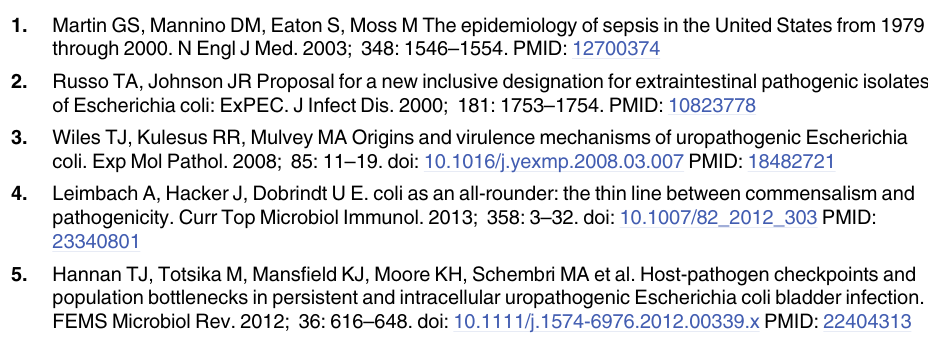
S6 Fig. Flow cytometry analysis of the Gr1 + and CD11b + populations. (A and B) Flow cy- tometry analysis of peripheral blood isolated from mice intravenously infected with 10 7 CFUs of (A) E . coli CNF1+ , E . coli CNF1- (B) E . coli CNF1+HLY- , or E . coli CNF1+HLY+ . The percentages of cells expressing CD45 and CD11b or CD45 and Gr1 are indicated (n = 5). S7 Fig. Flow cytometry analysis of the antibody-triggered depletion of the Gr1 + population. Flow cytometry analysis of white blood cells isolated after 48 h by Ficoll-Paque gradient to as- sess the depletion of the Gr1 + population (pooled blood samples from 3